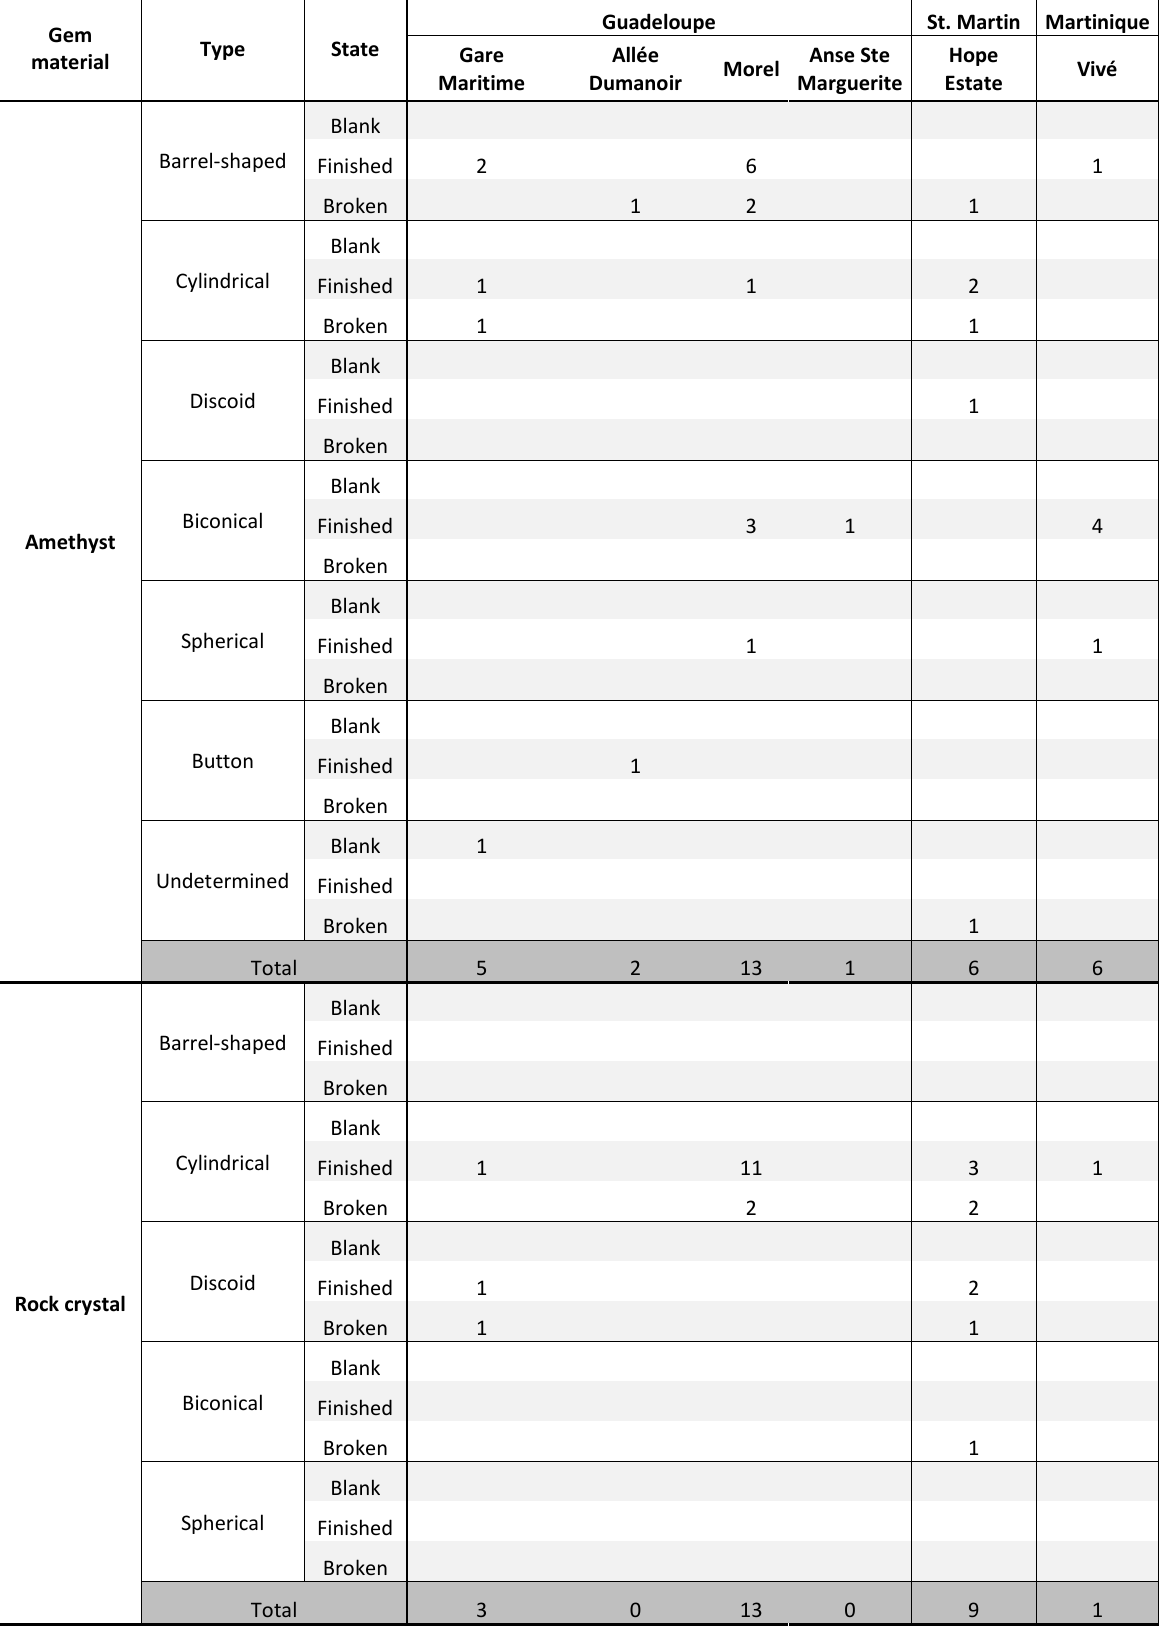
Table 1: Distribution of the types of amethyst and rock crystal beads in the different Early Ceramic sites